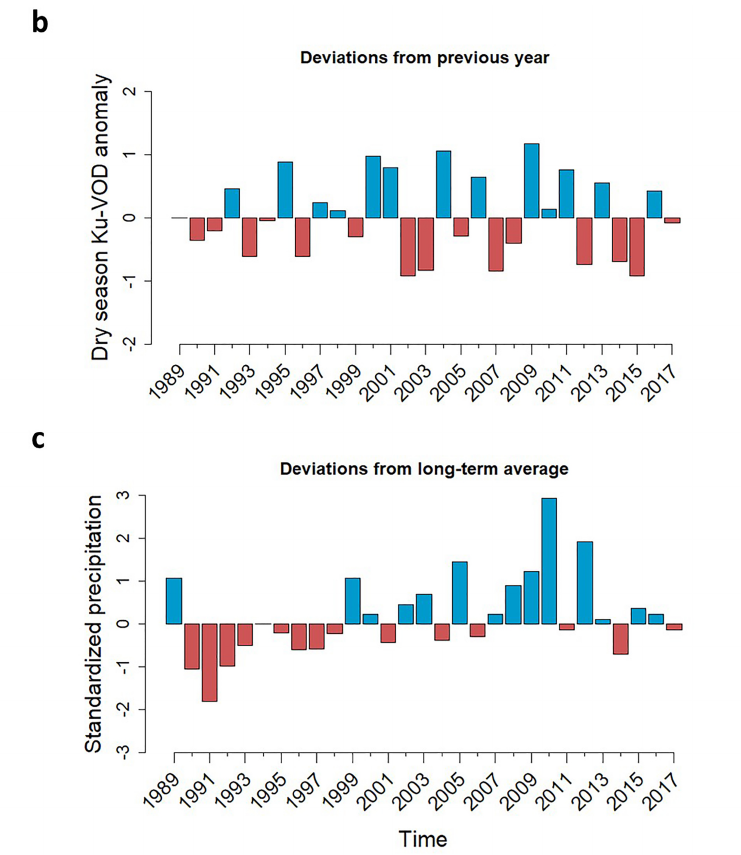
Figure 5. ( a ) Dry season Ku-VOD anomalies in relation to the long-term average (1989–2017) and ( b ) to the previous year. Total dry season Ku-VOD values were calculated by summing the values for all the pixels inside our study area and were used as an estimation of the standing woody biomass. ( c ) Standardized precipitation, calculated as the annual precipitation anomaly divided by the standard